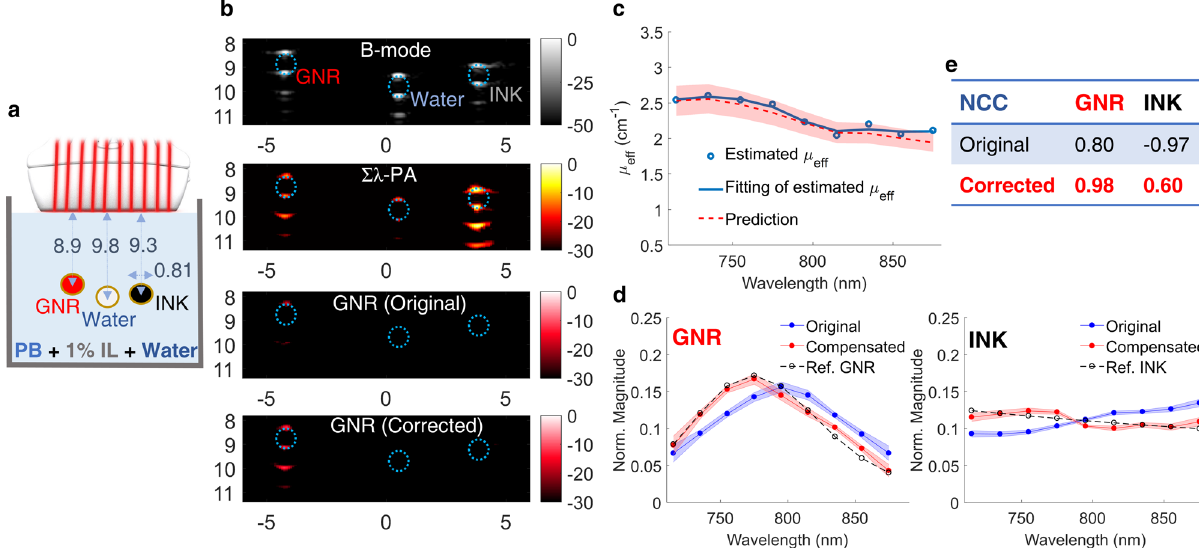
Fig. 3 Phantom spectroscopic PA imaging with optical fl uence compensation. GNR (gold nanorods), de-ionized water, and black ink were injected into three different tubes immersed in an absorbing and highly scattering background (1% Intralipid suspension mixed with Prussian blue nanoparticles). a Experimental setup. b First row: B-mode image. Second row: wavelength-compounded, Σλ -PA, image. Third/Fourth row: GNR-weighted PA image without/with optical fl uence compensation. The horizontal and vertical axes represent lateral and axial dimensions in units of mm, respectively. Wavelength-dependent fl uence was estimated using PA signals at the top of the tube fi lled with black ink. c The estimated effective optical attenuation coef fi cient ( μ eff , blue line) is compared to predictions using the UV – VIS measured absorption coef fi cient of Prussian blue aqueous solution and the reduced scattering coef fi cient of Intralipid known from the literature 58 (red shaded region). d Measured spectra (normalized to the area under the spectrum) of GNR (left) and black ink (right) are expressed as mean ± standard deviation. For each panel, the spectrum after fl uence compensation (red solid line) is compared to the uncompensated spectrum (blue line) and the reference UV – VIS result (dashed line). e Improvements after fl uence compensation for GNR and black ink solutions are quanti fi ed in terms of the averaged normalized correlation coef fi cient